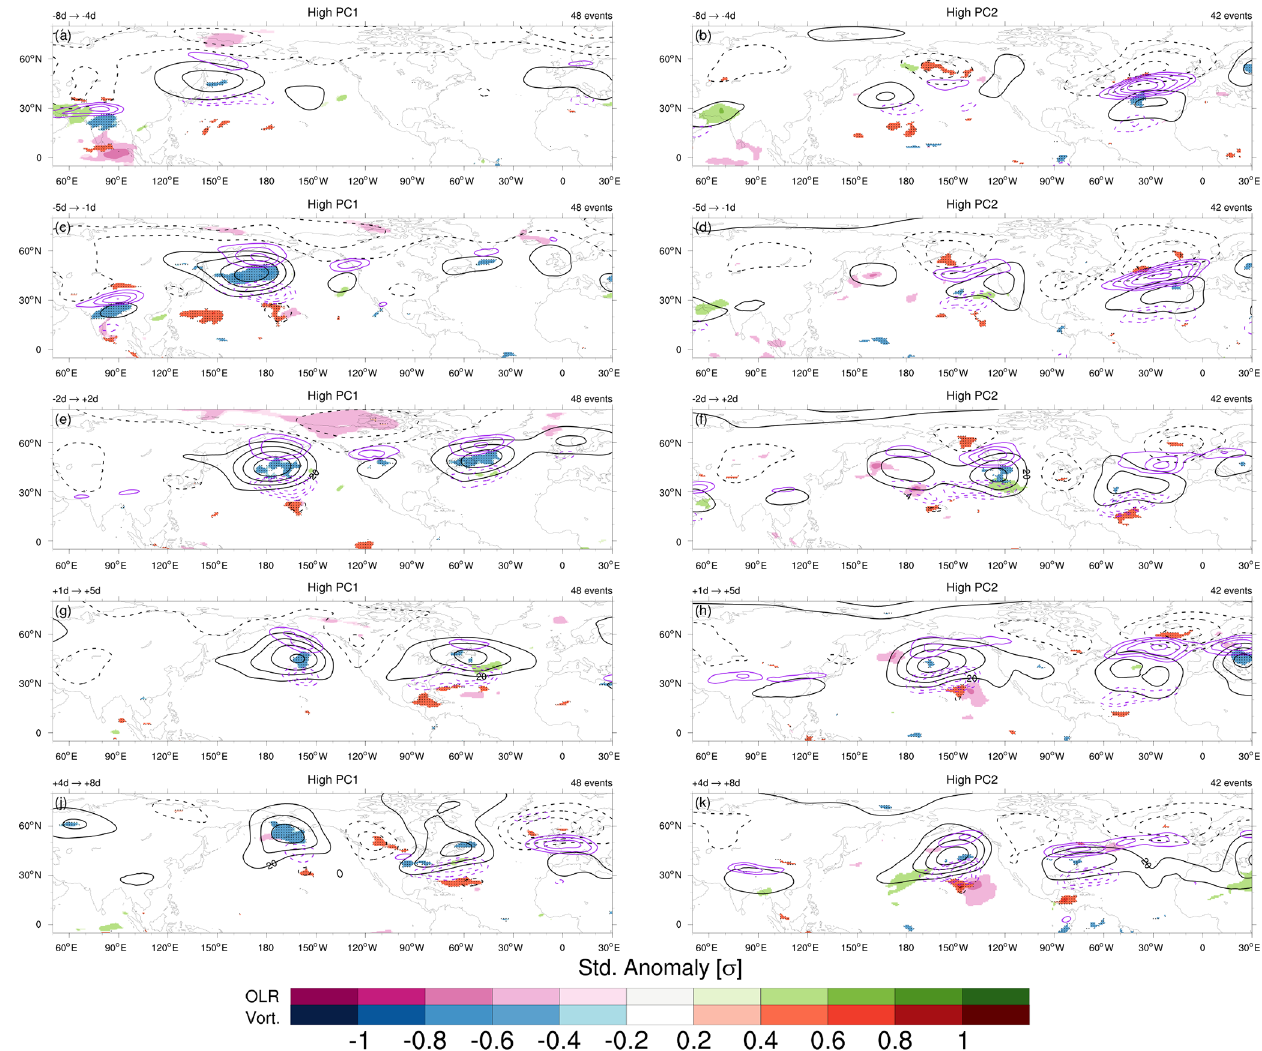
Figure 6. Lagged composites of significant ( p < 0 . 01, two-sided t test) pentad-mean standardized anomalies of OLR and 250hPa relative vorticity (shaded) for (left) CRWP1 and (right) CRWP2 events for the pentads centered at (a, b) t max − 6d, (c, d) t max − 3d, (e, f) t max , (g, h) t max + 3d and (j, k) t max + 6d. Stippling is added on top of vorticity anomalies to better distinguish them in case of overlap. Contours of pentad-mean 250hPa geopotential height anomalies (black contours, between − 80 and + 80m every 20m excluding zero) and positive 250hPa zonal wind anomalies (purple contours, between 4 and 7ms − 1 in steps of 1ms − 1 ) are